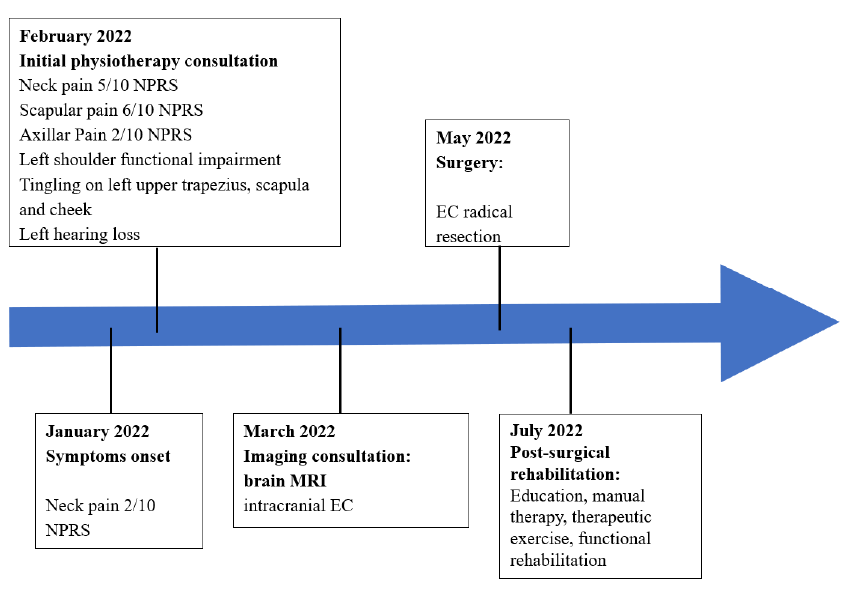
Figure 1. Timeline. Acronyms: MRI: magnetic resonance imaging; EC: epidermoid cyst; NPRS: Numeric Pain Rating Scale.